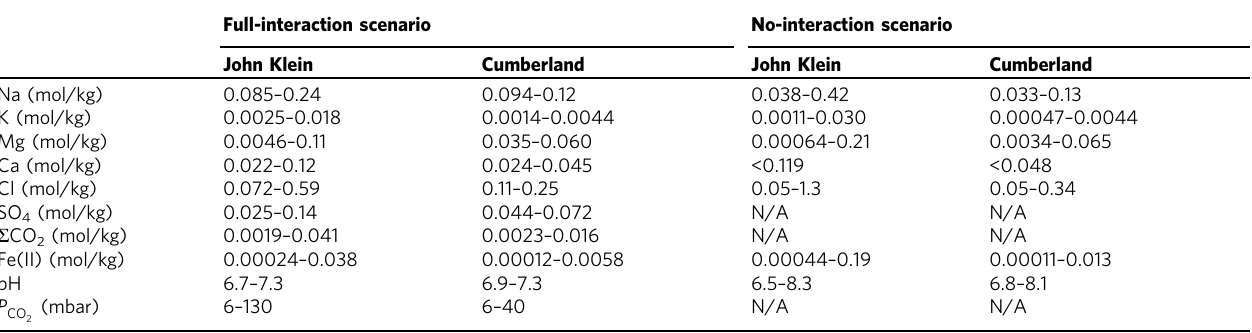
Table 1 Estimated solution compositions of pore water that fi nally interacted with sediments at John Klein and Cumberland for (a) full-interaction scenario and (b) no-interaction